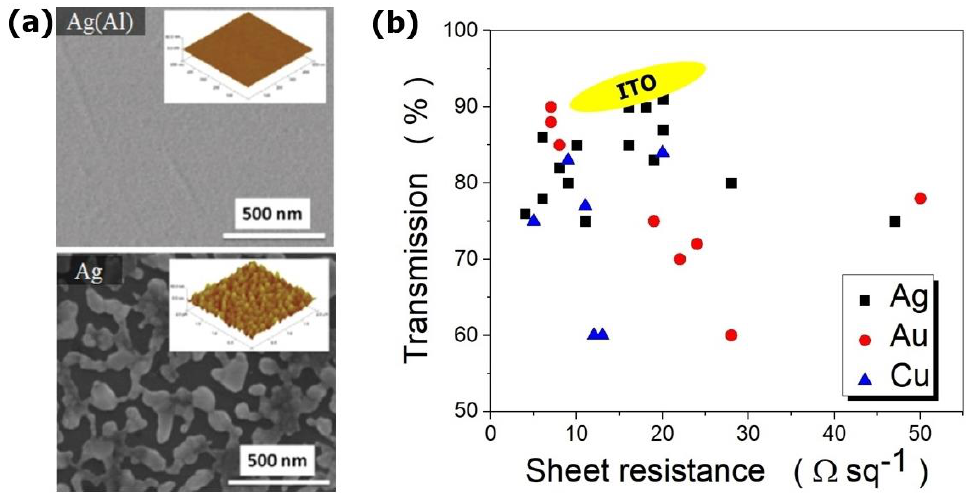
Figure 6. ( a ) Island formation of an ultrathin Ag transparent conducting film leading to a rough surface morphology (bottom), which can be avoided by doping with Al (top) (Reproduced by permission from ref. [79]). ( b ) Transmission versus sheet resistance performance of a range of ultrathin Ag, Au, and Cu films produced with seed layers and / or doping. Ultrathin metal films can outperform ITO in terms of sheet resistance, but they generally have lower